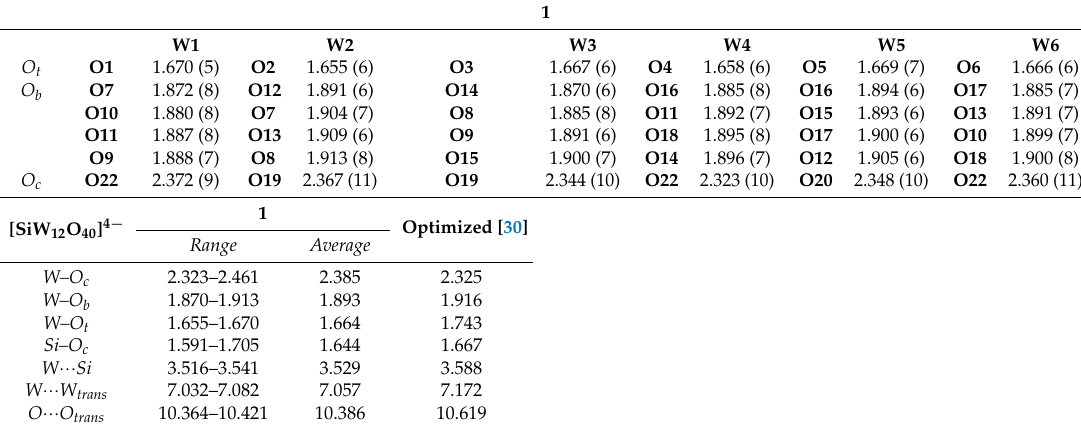
Table A1. W-O and Si-O C bond lengths and W ··· Si, W ··· W trans and O ··· O trans (Å) distances for